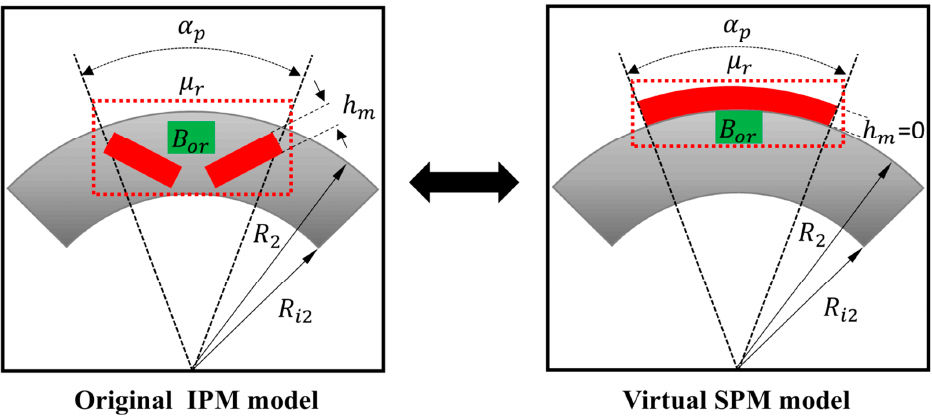
Figure 7. The equivalent virtual SPM model for IPM relative permeance 2D model derivation.